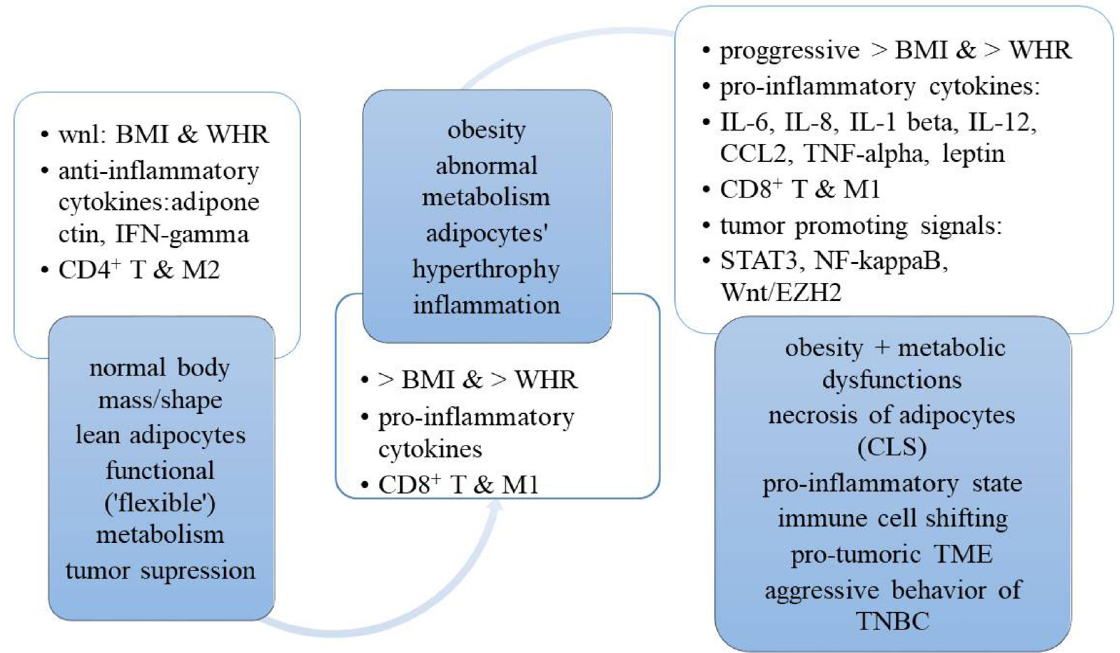
Figure 2. A transition from normal body mass/shape and metabolism to obesity, dysfunctional metabolism and pro-inflammatory/ pro-tumoric “milieu” for TNBC. CCL2: chemokine (C-C motif) ligand 2; CLS: crown-like structures; wnl: within normal